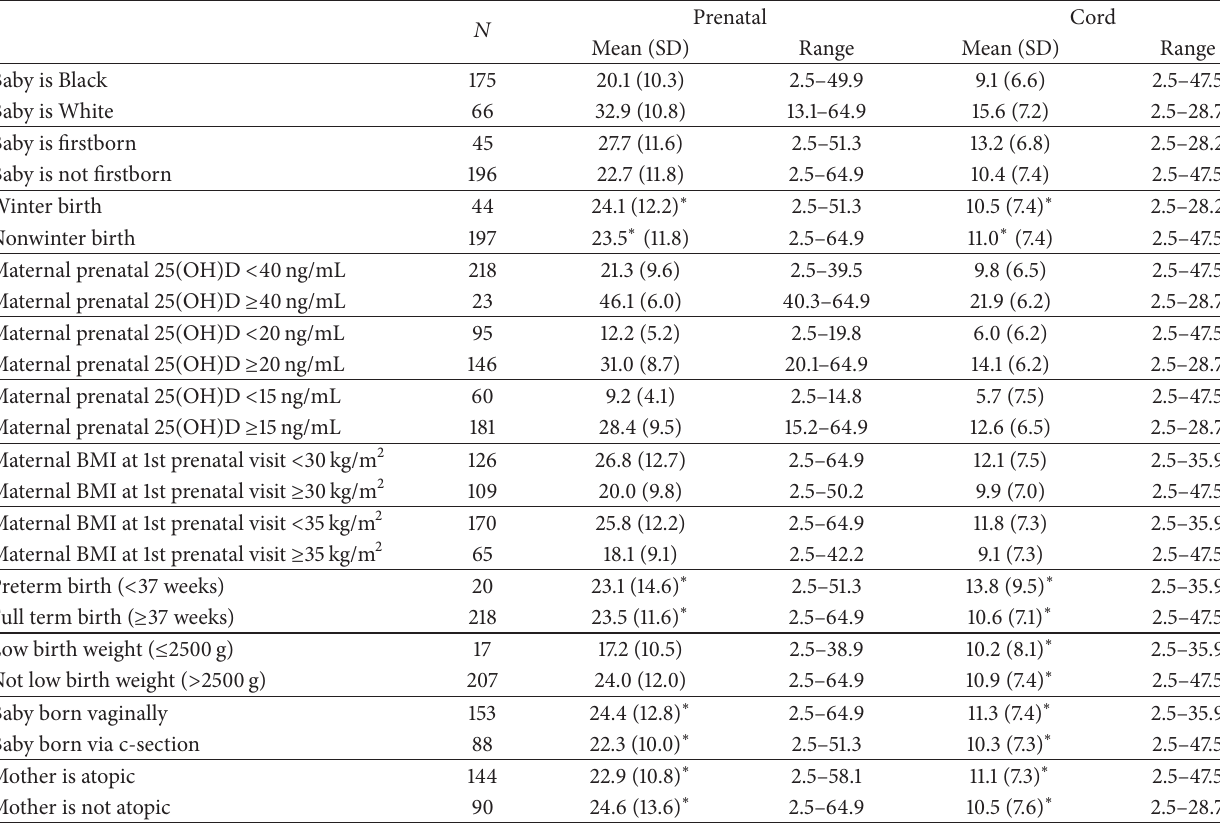
Table 2: 25(OH)D levels for prenatal 25(OH)D and cord blood 25(OH)D. Values are in ng/mL.